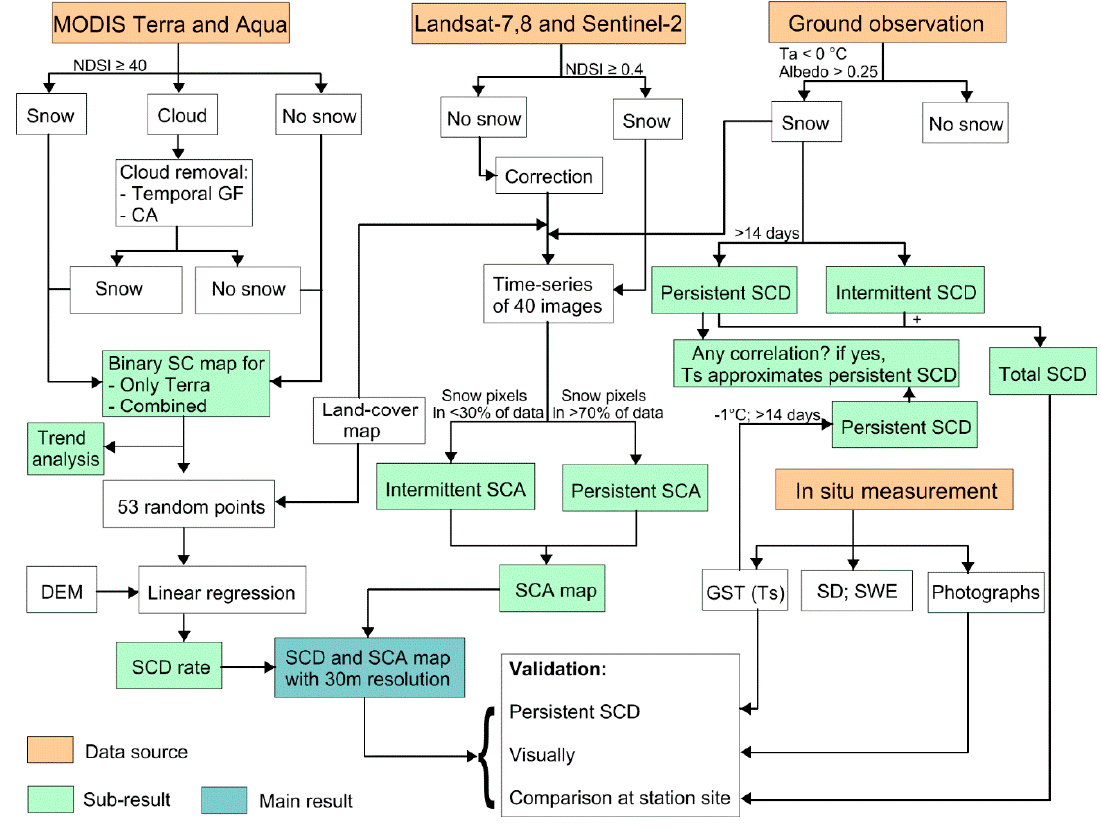
Figure 2. Flowchart of the procedure to map snow cover duration (SCD) and snow cover area (SCA) in the Sugnugur catchment. MODIS is Moderate Resolution Imaging Spectroradiometer. NDSI is normalized difference snow index. GF and CA are gap-filling and conditional adjustments, respectively. T s and T a denote daily mean ground surface temperature (GST) and daily mean air temperature, respectively. SD and SWE are snow depth and water equivalent, respectively.